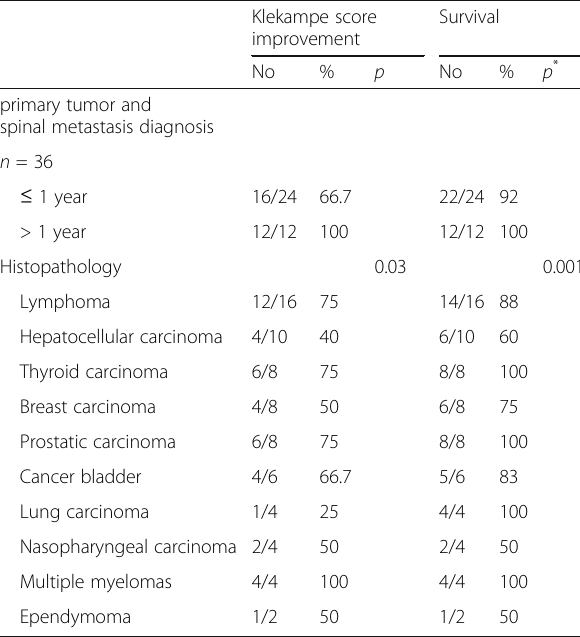
Table 8 Ninth month postoperative outcome (Klekampe score improvement and survival)